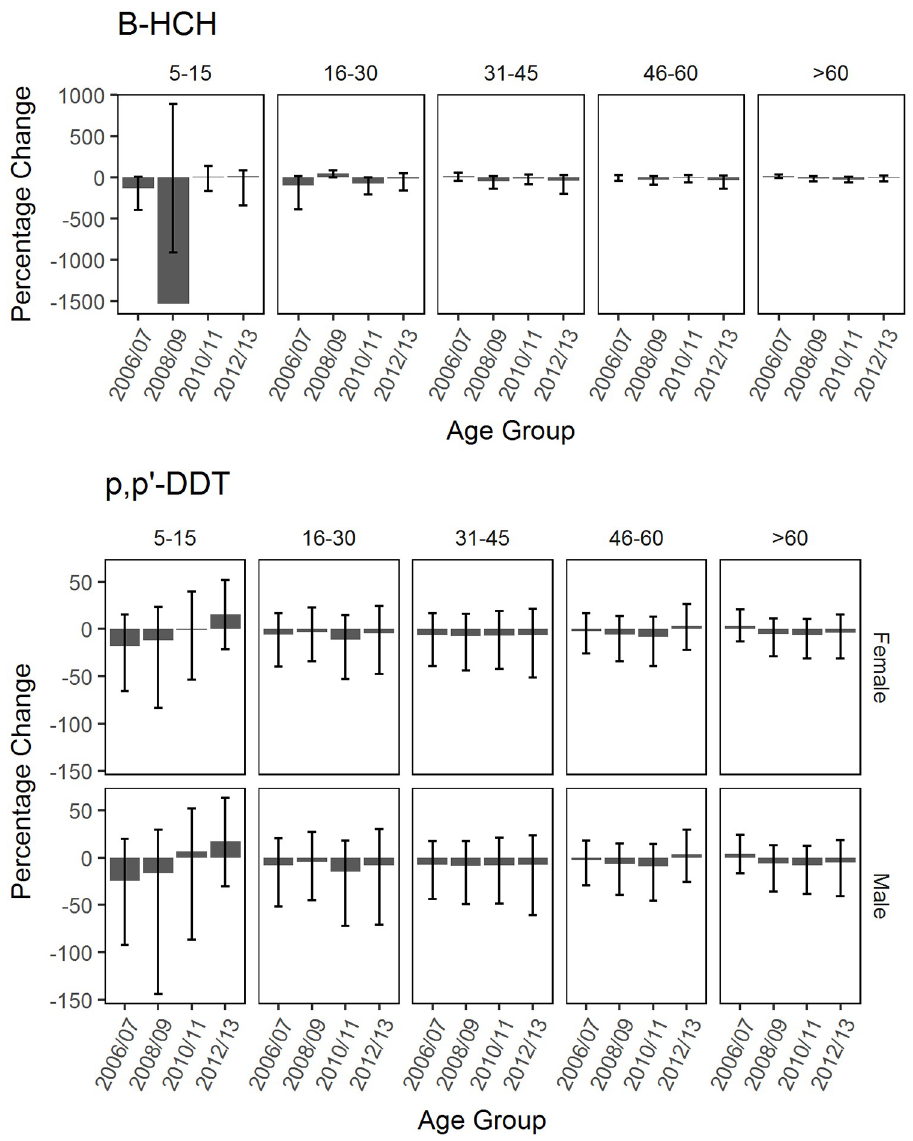
Fig 7. Percent change in OCP concentrations between consecutive sampling times. The percent change (%) of β - HCH and p,p’ -DDT concentrations (ng/g lipid) between each consecutive sampling times for age groups 5-15, 16-30, 31-45, 46-60 and > 60. For each age group, the sampling times listed from left to right indicate the differences between 2002/03 and 2006/07, 2006/07 and 2008/09, 2008/09 and 2010/11, and 2010/11 and 2012/13. The error bars for each age group indicate the 95% credible interval of the percent